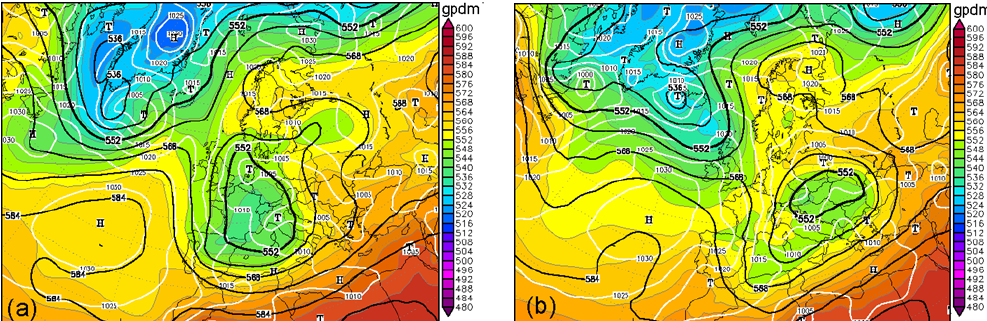
Figure 2. Weather charts for 30 May (a) and 1 June 2013 (b) 00:00UTC with analysis of 500hPa geopotential height (black lines), surface pressure (white lines) and 1000/500hPa relative topography (colours) from the Global Forecast System (GFS). Image credit: wetter3.de (last access: 7 May 2014).